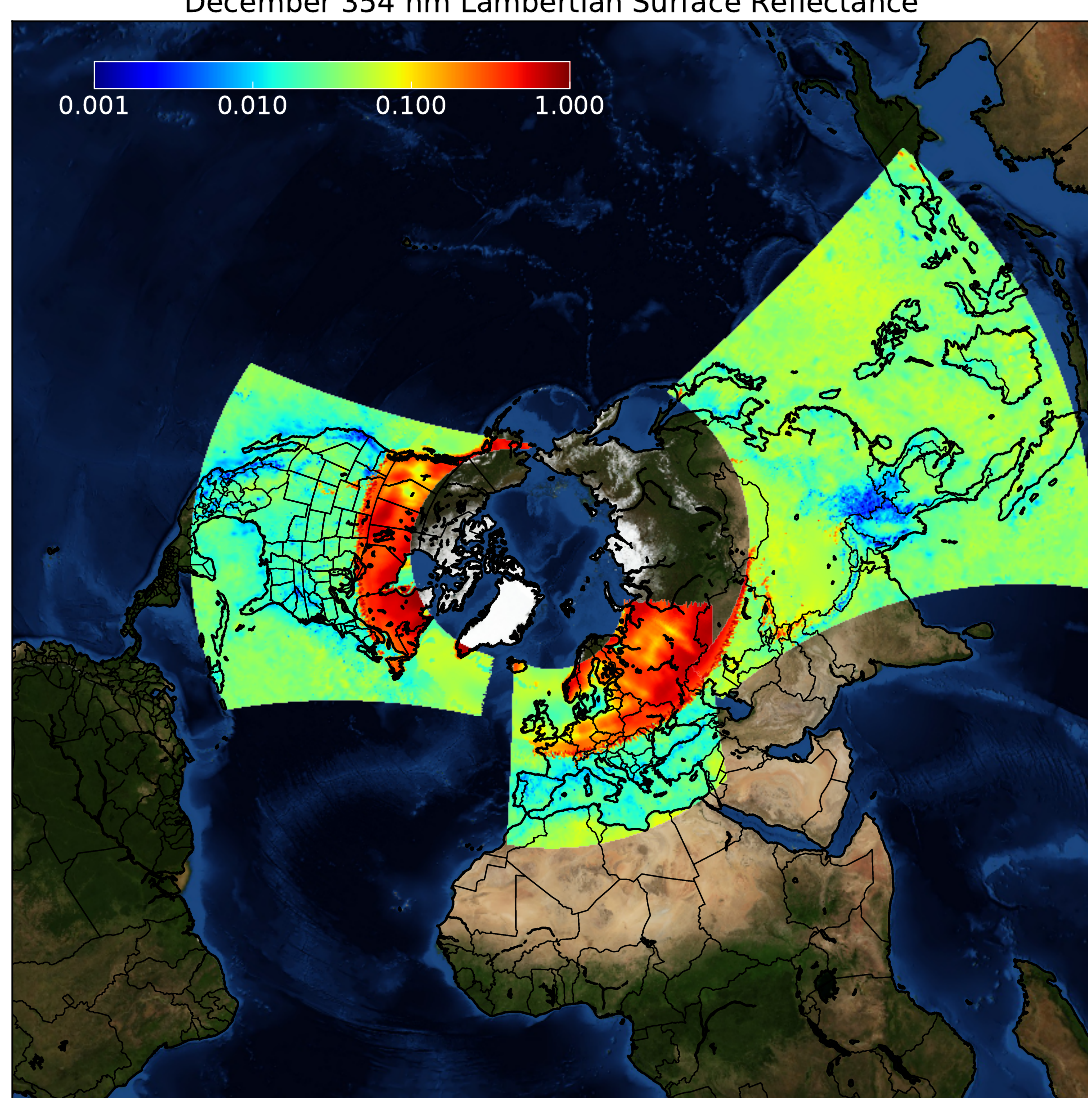
Figure 8. Lambertian equivalent reflectance mapped to the TEMPO grid from a 0.25 ◦ monthly climatology based on TOMS